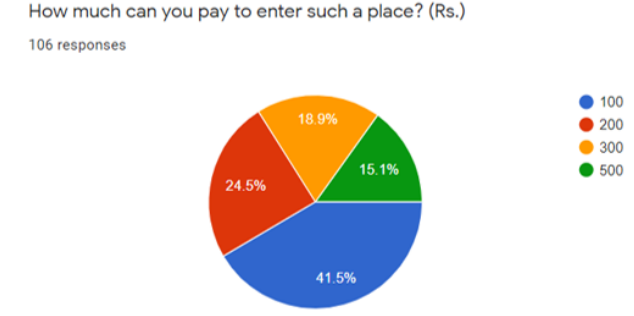
Figure 5: Affordablity to access urban forest and recreational area in terms of PKR per entry for general facilities proposed for urban forest